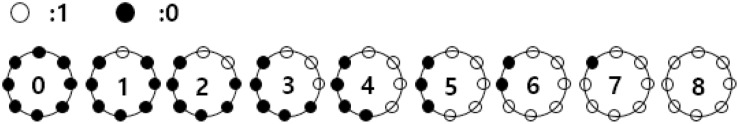
Nine uniform LBP patterns.